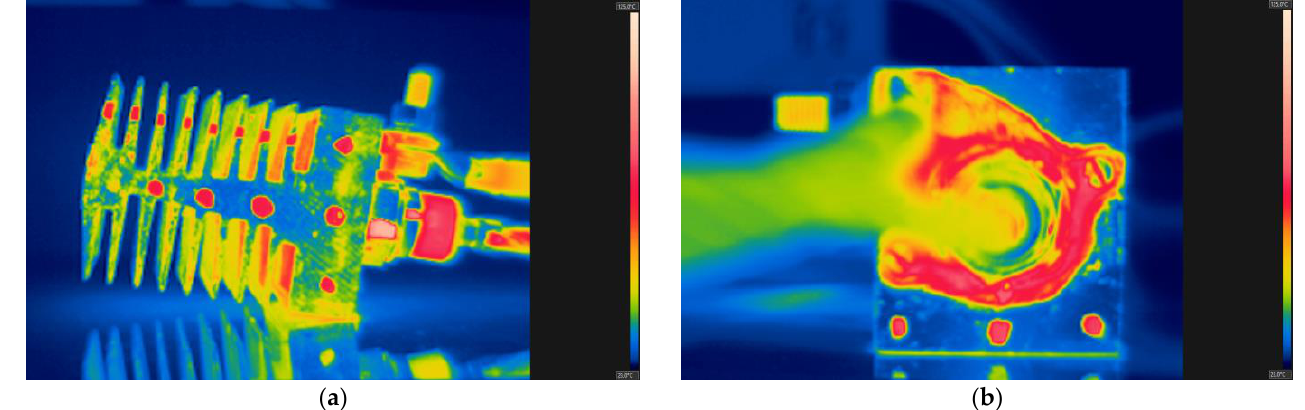
Figure 7. The thermograms showing a heat sink for a power of P j = 74.36 W: ( a ) side view; ( b ) top view. The temperature on the thermogram ranges from 23 °C to 125 °C.